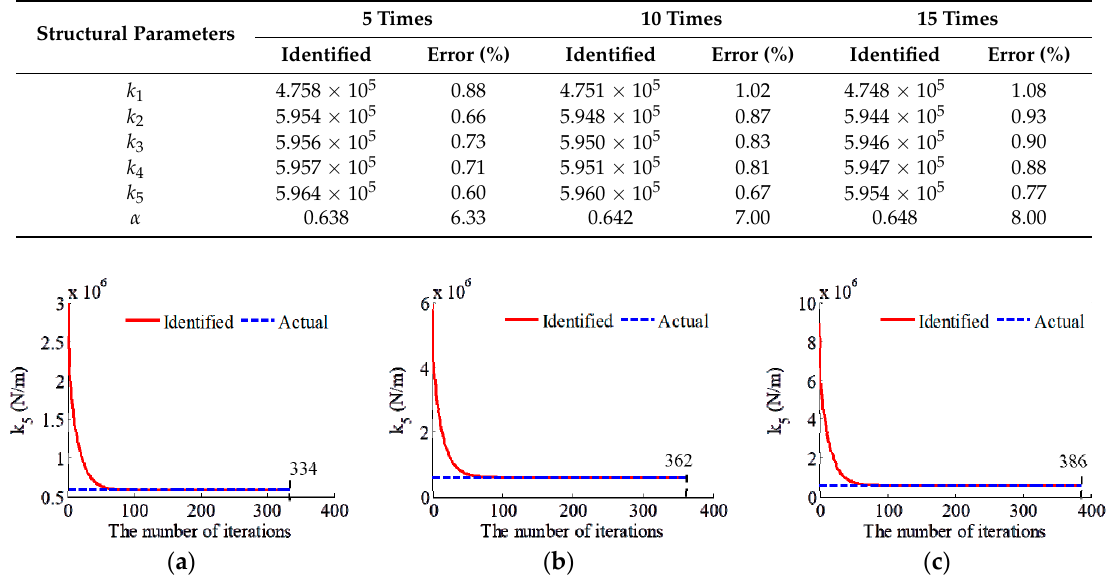
Figure 9. Comparison of the identified k 5 with different initial values: ( a ) 5 times; ( b ) 10 times; ( c ) 15